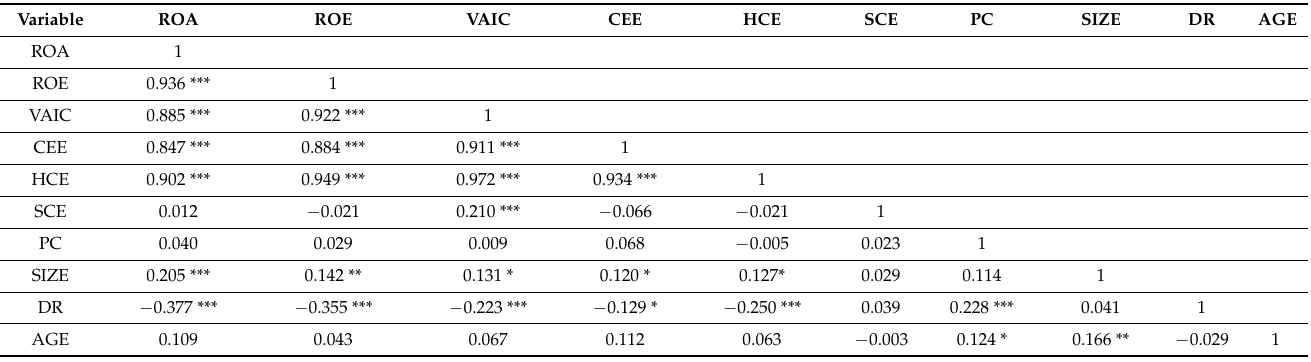
Table 5. Correlation analysis of the VAIC model.